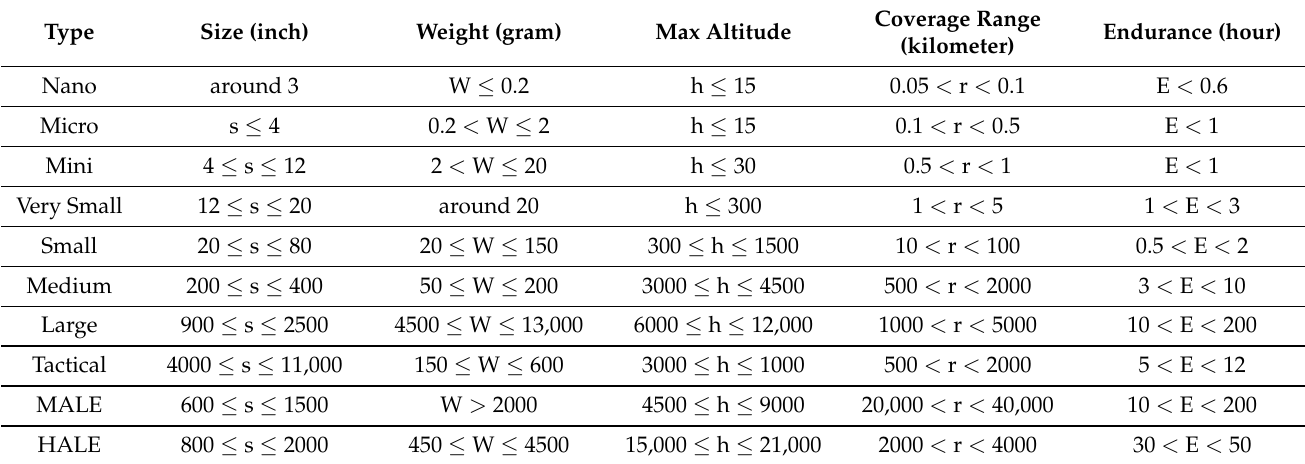
Table 1. UAV Classification based on size, weight, altitude, coverage, range, and